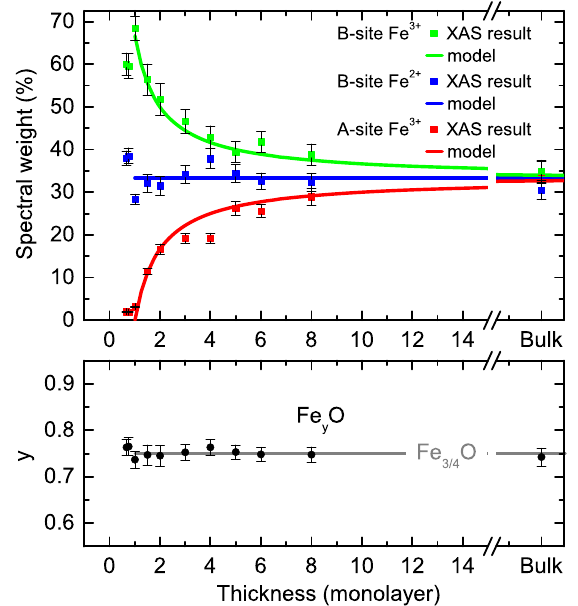
FIG. 3. The extracted spectral weight of each Fe site versus the film thickness. The spectral weight of the B-site Fe 3 þ , the B-site Fe 2 þ , and the A-site Fe 3 þ are given by the green, blue, and red squares, respectively. Green, blue, and red curves depict the concentrations of the B-site Fe 3 þ , the B-site Fe 2 þ , and the A-site Fe 3 þ , respectively, in our model (see the text). The Fe content ( y ) of the Fe y O films derived from the average valence is shown in the bottom panel. The error bars reflect the deviations of the fits to the experimental